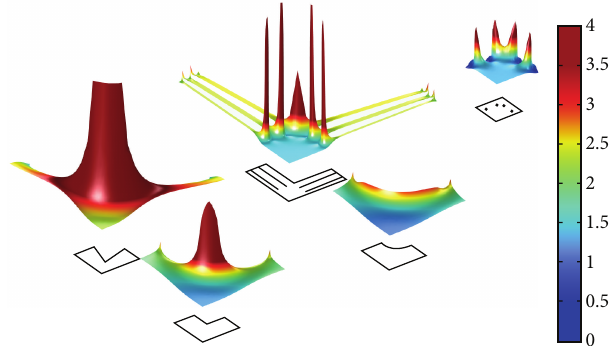
Figure 9: Maps of von Mises stress (MPa) with underlying initial shape of the specimens (one-quarter of the nominal geometry).